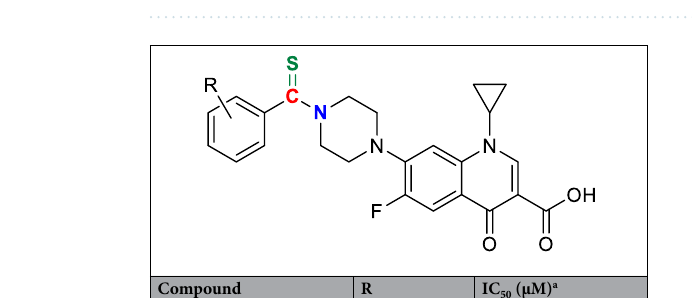
Figure 3. A plausible mechanism for the preparation of 3a .